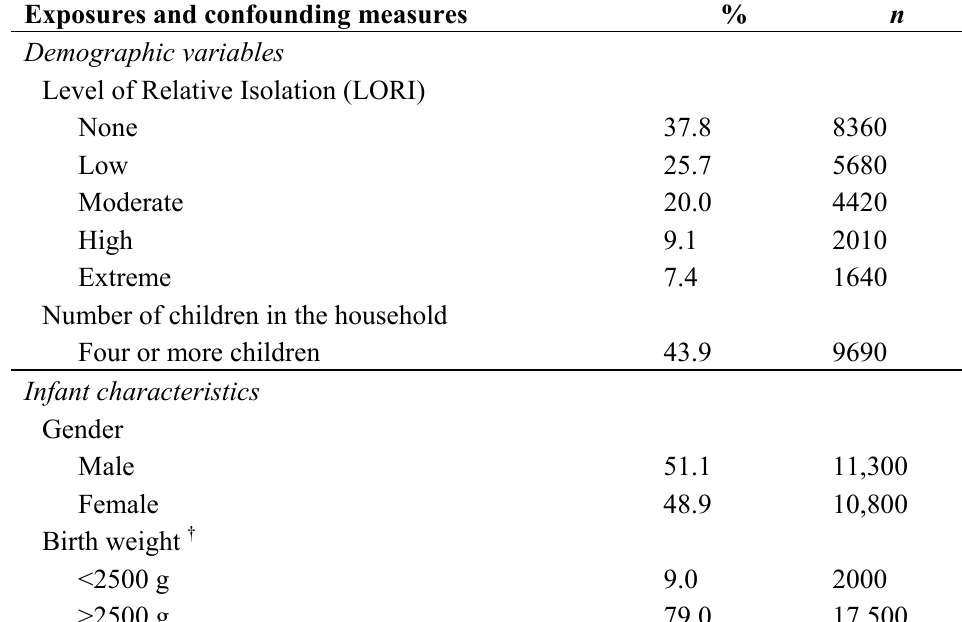
Table 1. Demographic, maternal and infant characteristics of Western Australian Aboriginal Exposures and confounding measures